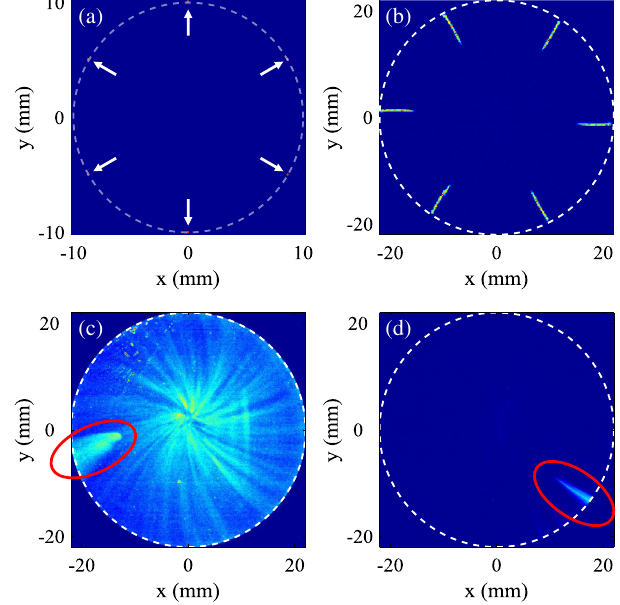
FIG. 10. (a) The initial edge emitters distribution used in the ASTRA simulation. The white dashed circle represents the ∅ 20 mm cathode edge, and the white arrows point to the six emitters. (b) Simulated transverse distribution of field emission electrons from the six emitters on YAG 1 . (c) Experimental observation with the (N)UNCD cathode on YAG 1 . (d) Exper- imental observation with a molybdenum cathode on YAG 1 . In (b) – (d), the images were simulated or taken with the same E c; and B f settings. The white dashed circle represents the ∅ 44 mm YAG boundary. The red circles mark electrons from edge